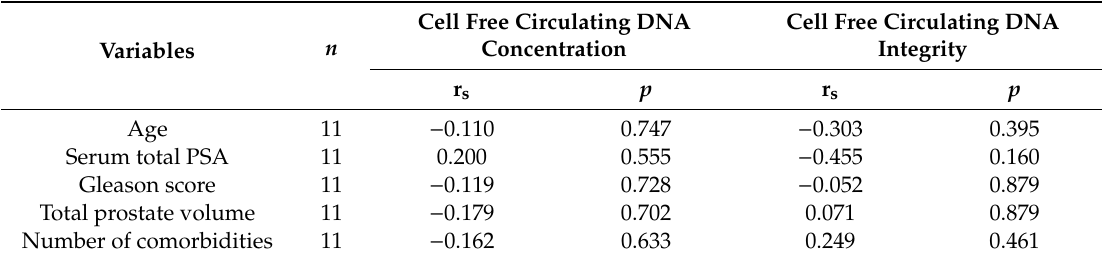
Table 2. Correlation between cell free circulating DNA and cell free circulating DNA integrity di ff erent variables of patients with prostate cancer.